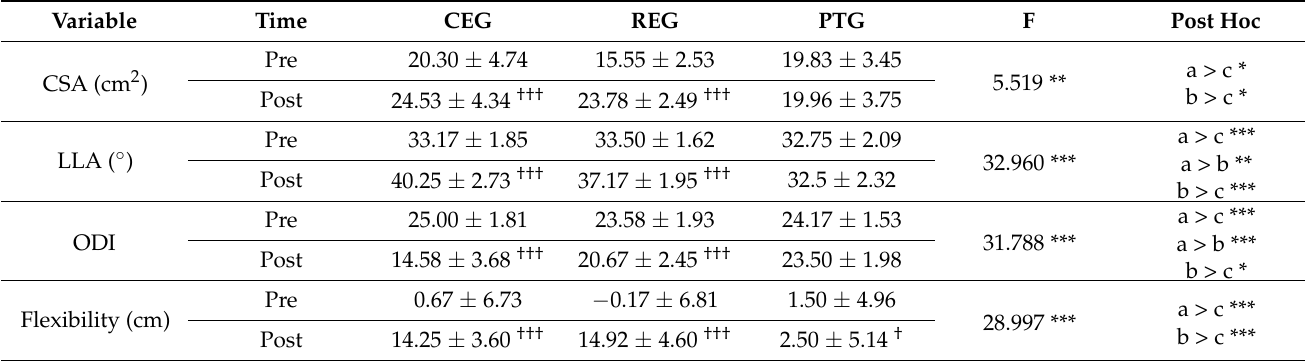
Table 4. Changes in clinical outcomes after the